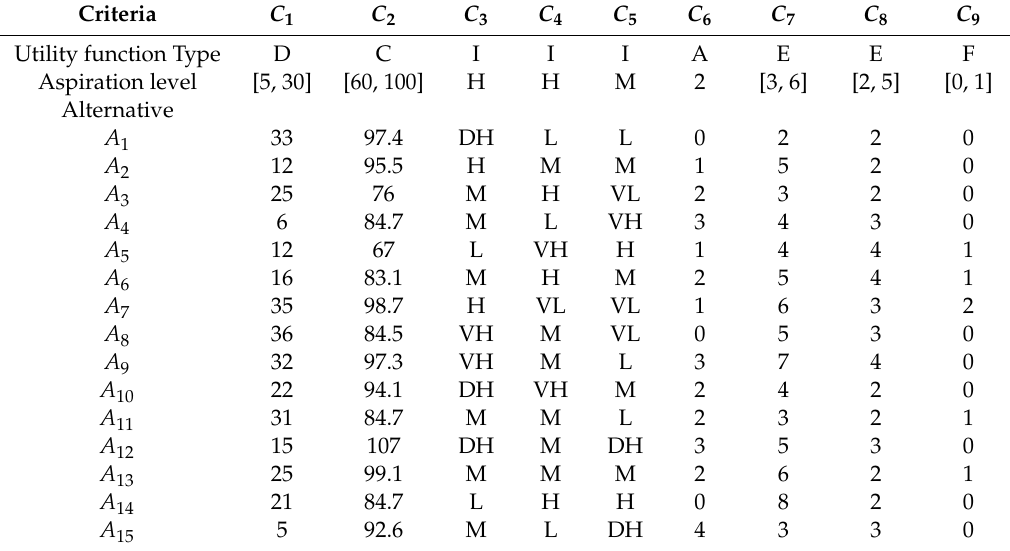
Table 5. Original decision